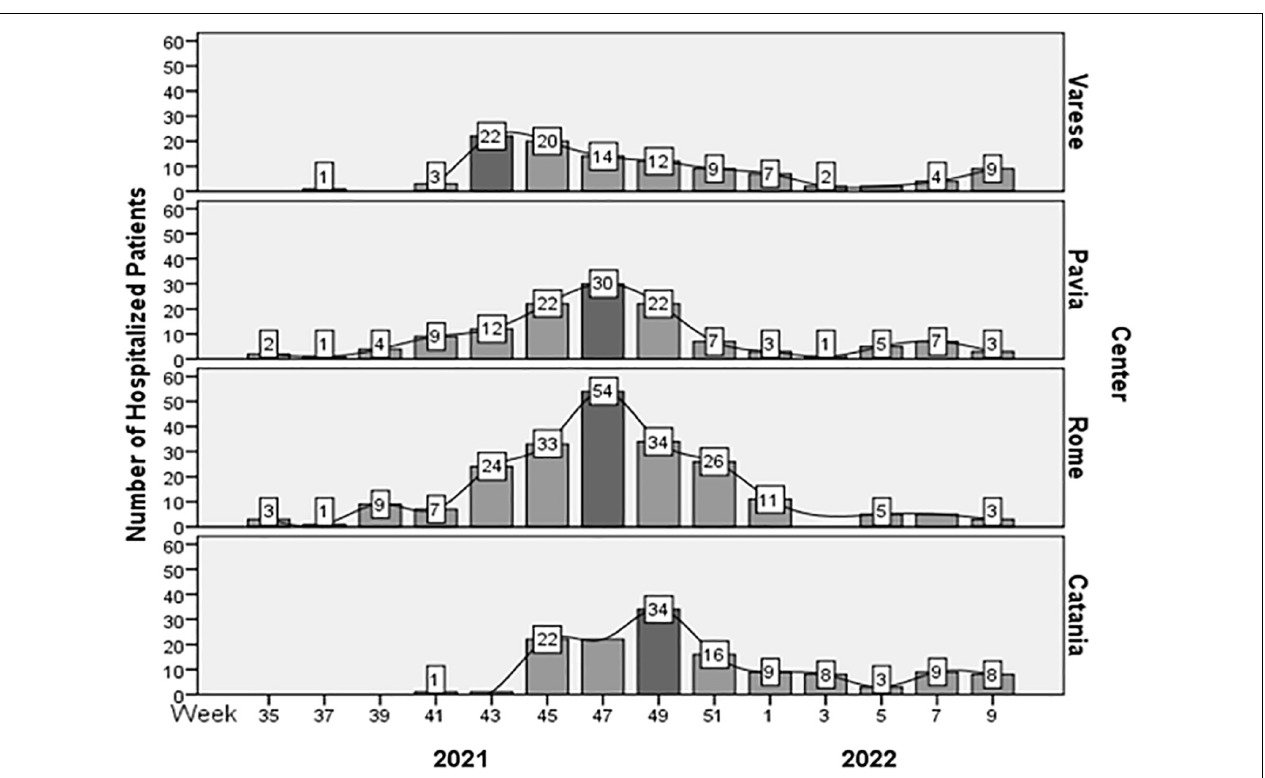
FIGURE 1 | Distribution of hospitalized patients for respiratory diseases from September 1, 2021 to March 15, 2022. The epidemic peaks are highlighted in dark gray.